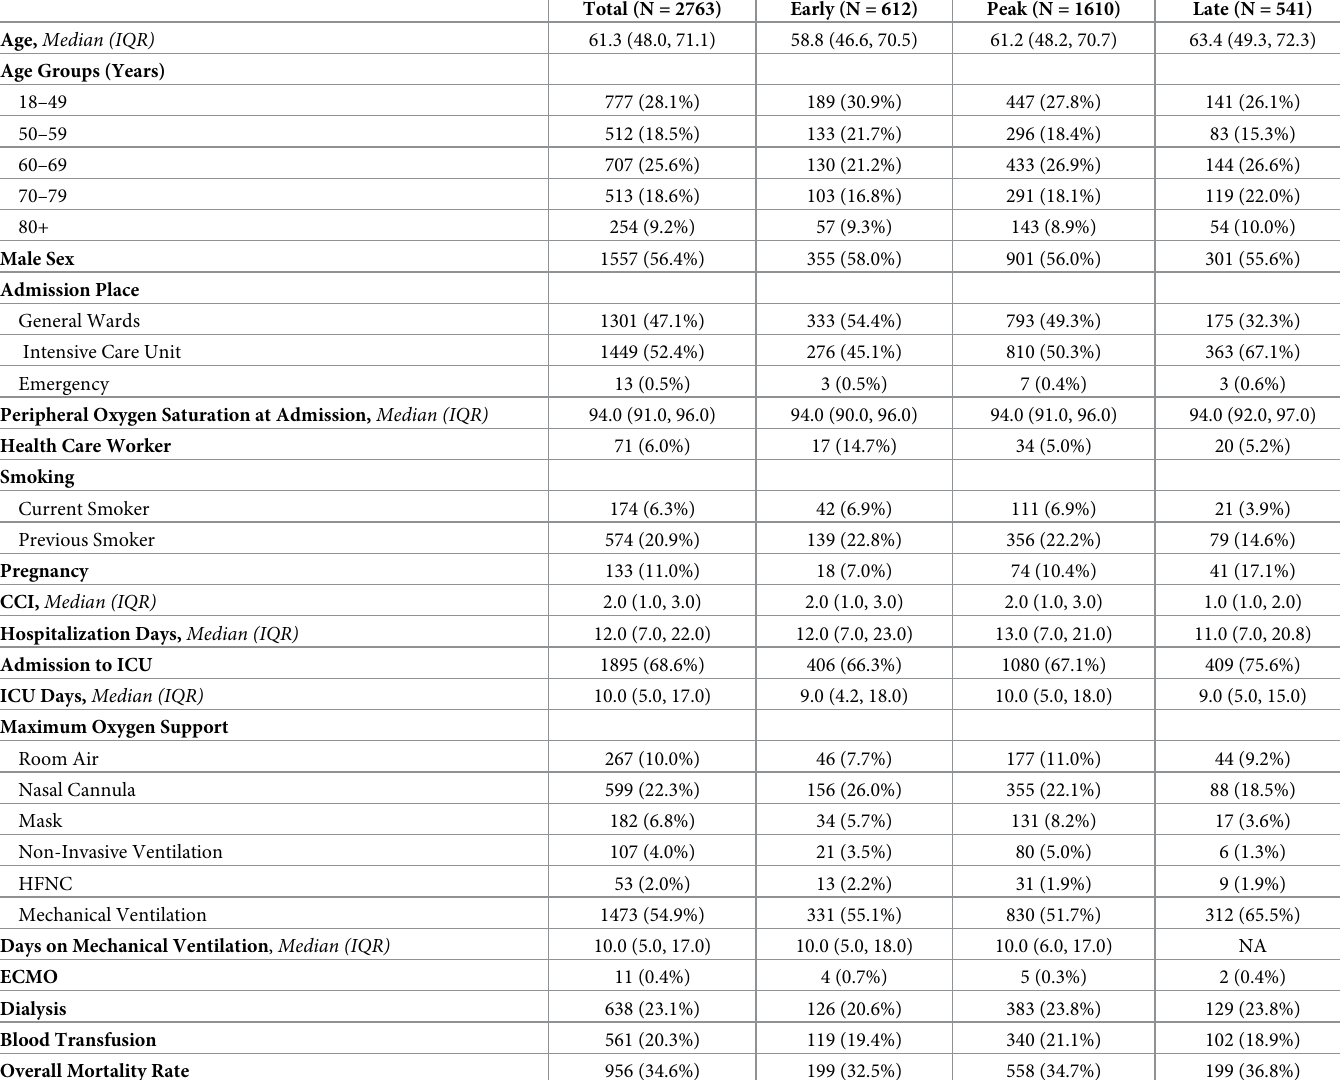
Table 1. Patient characteristic according to period of